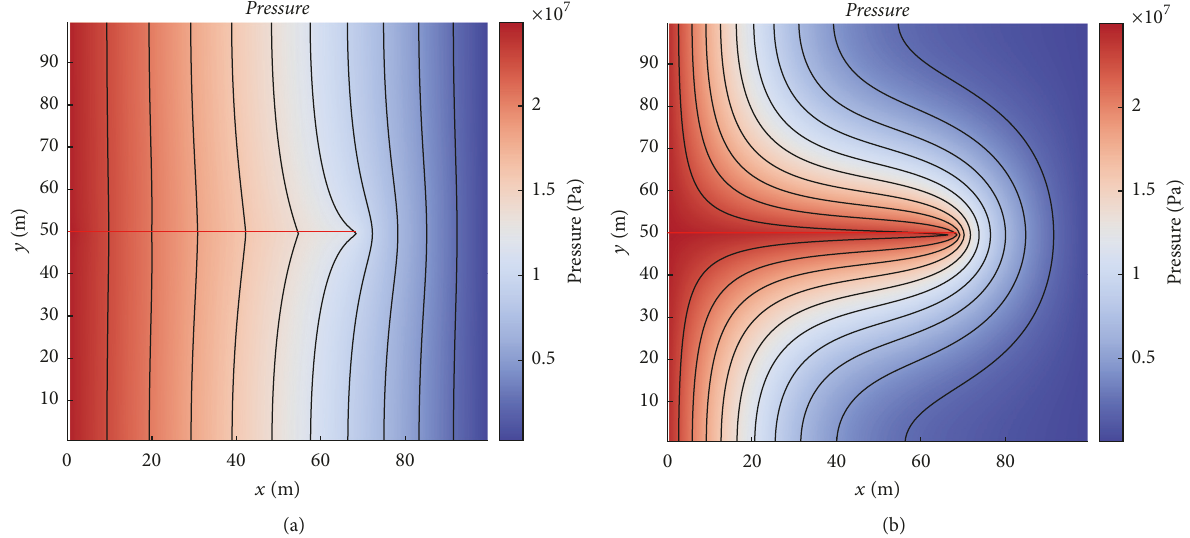
Figure 8: Pressure distribution after 30 days of injection. Fracture permeability 𝑘 fr = 10 −10 m 2 : (a): higher matrix permeability 𝑘 𝑚 = 10 −16 m 2 ; (b): lower matrix permeability 𝑘 𝑚 = 10 −18 m 2 .